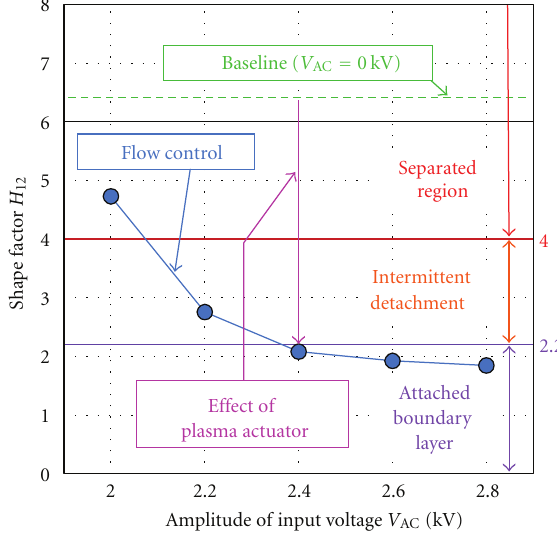
Figure 17: Shape factor H 12 near trailing edge ( x = 99.1 mm). From the correlation, the boundary layer at baseline and V AC = ± 2.0 kV is separated, that at V AC = ± 2.2 is intermittently detached, and that at V AC = ± 2.4, ± 2.6 and ± 2.8 kV is reattached.